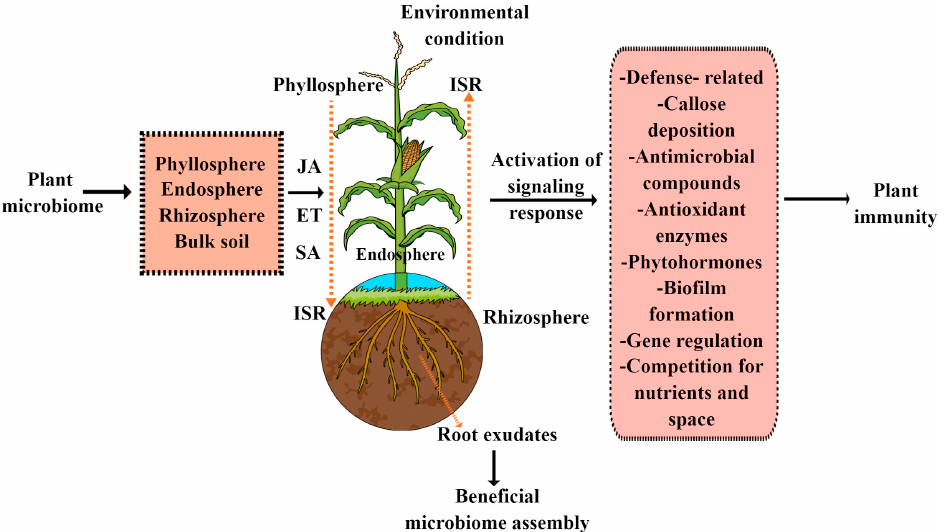
Figure 1. How plant microbiome (endosphere, phyllosphere, rhizosphere and bulk soil) confers disease resistance in plants. There are two types of microbiome-mediated disease resistance: direct, in which they secrete various antimicrobial chemicals, compete for resources and space and undergo callose deposition; and indirect, in which they activate the plant immune system, including ISR.